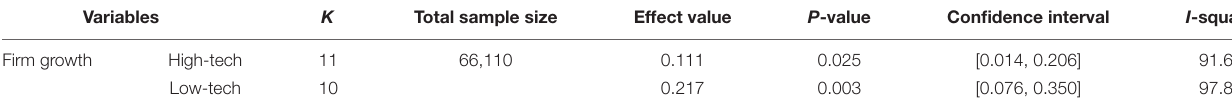
TABLE 4 | Moderating effect of industry conditions.